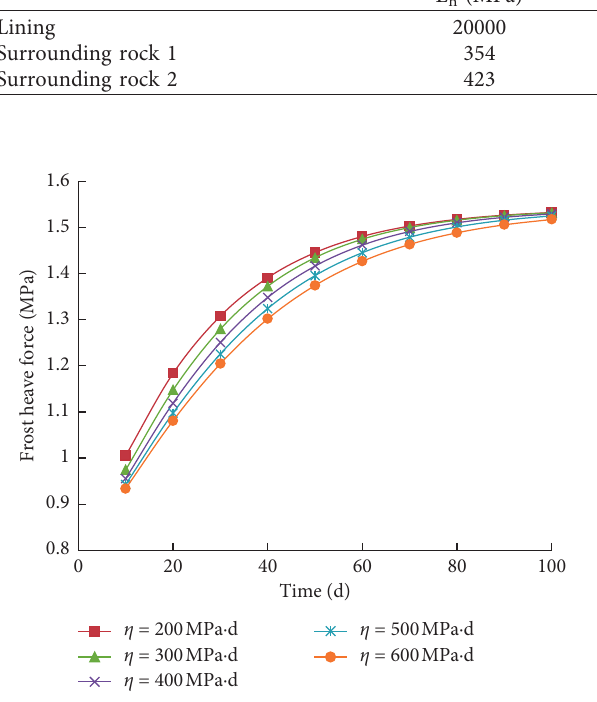
Figure 4: Frost heaving force-time curve under different viscosity coefficients.